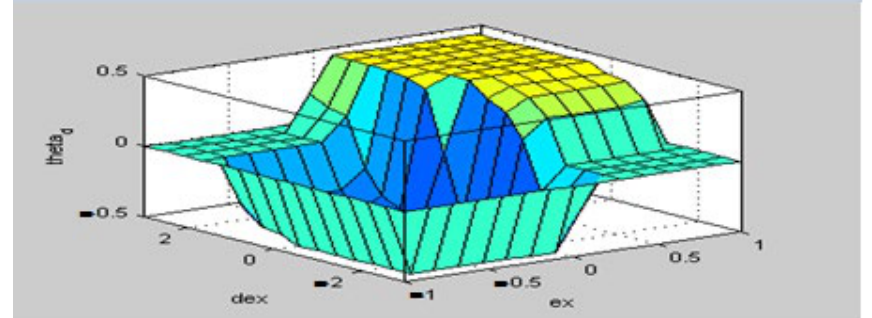
Figure 9. Surface view of FC (X), FC(Y), FC ( ϕ), FC (θ).